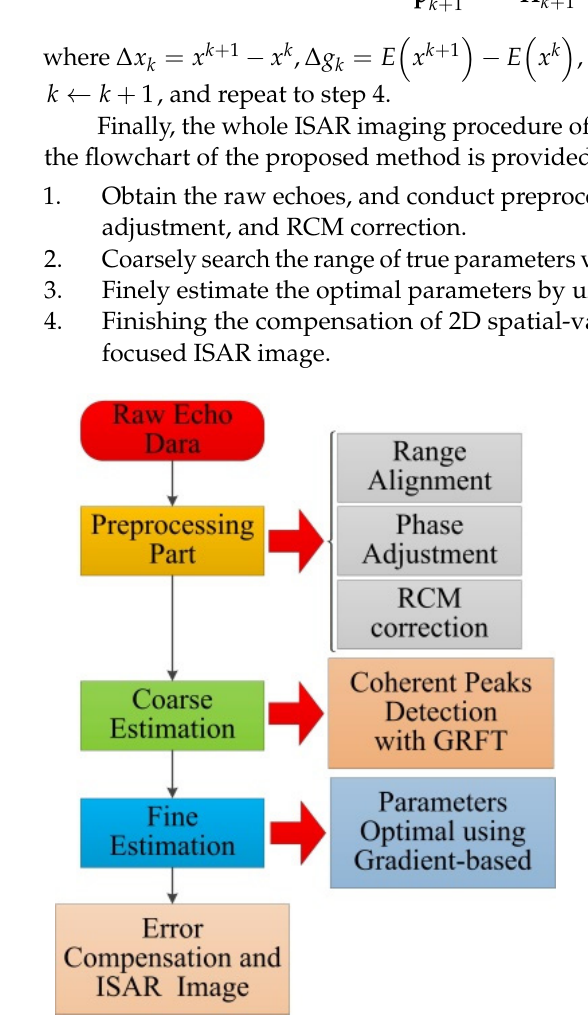
Figure 5. Flowchart of the proposed method.